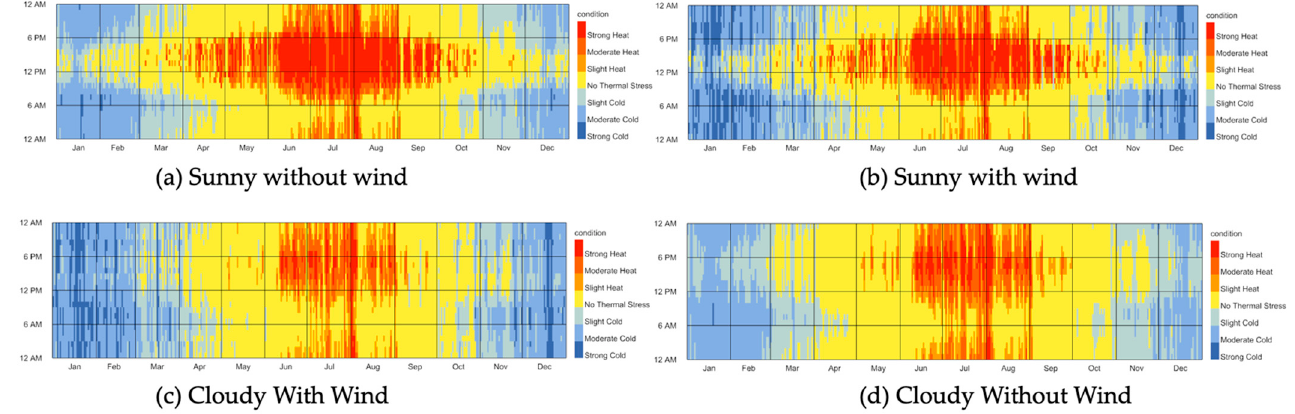
Figure 2. Examples of outdoor thermal comfort situations across one year in Beijing.